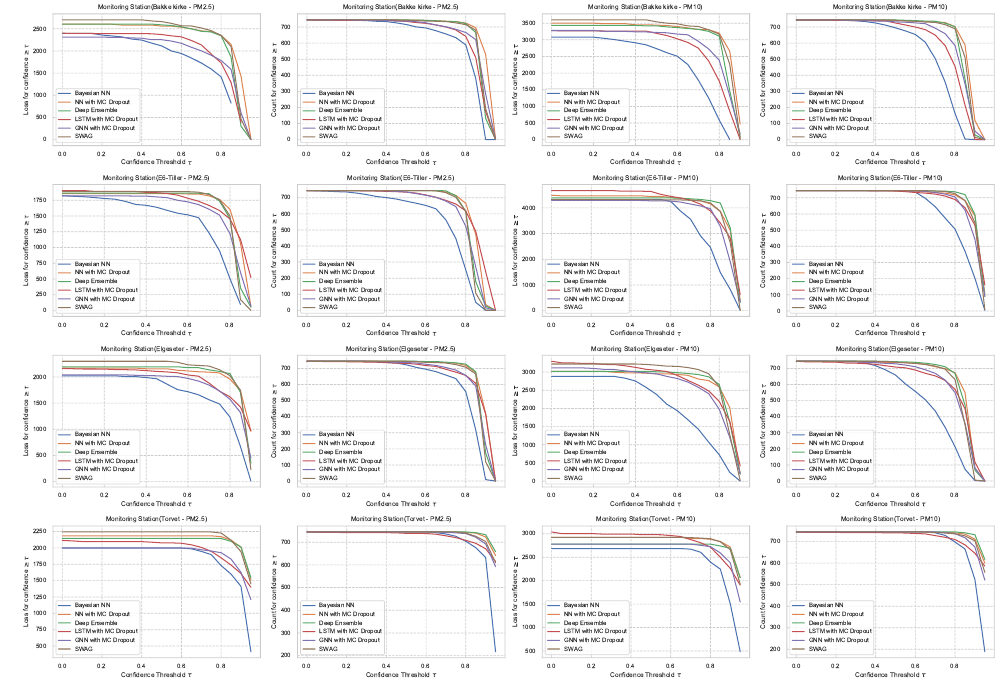
Figure A5. Comparison of confidence reliability for the selected probabilistic models in the PM-value regression task in all monitoring